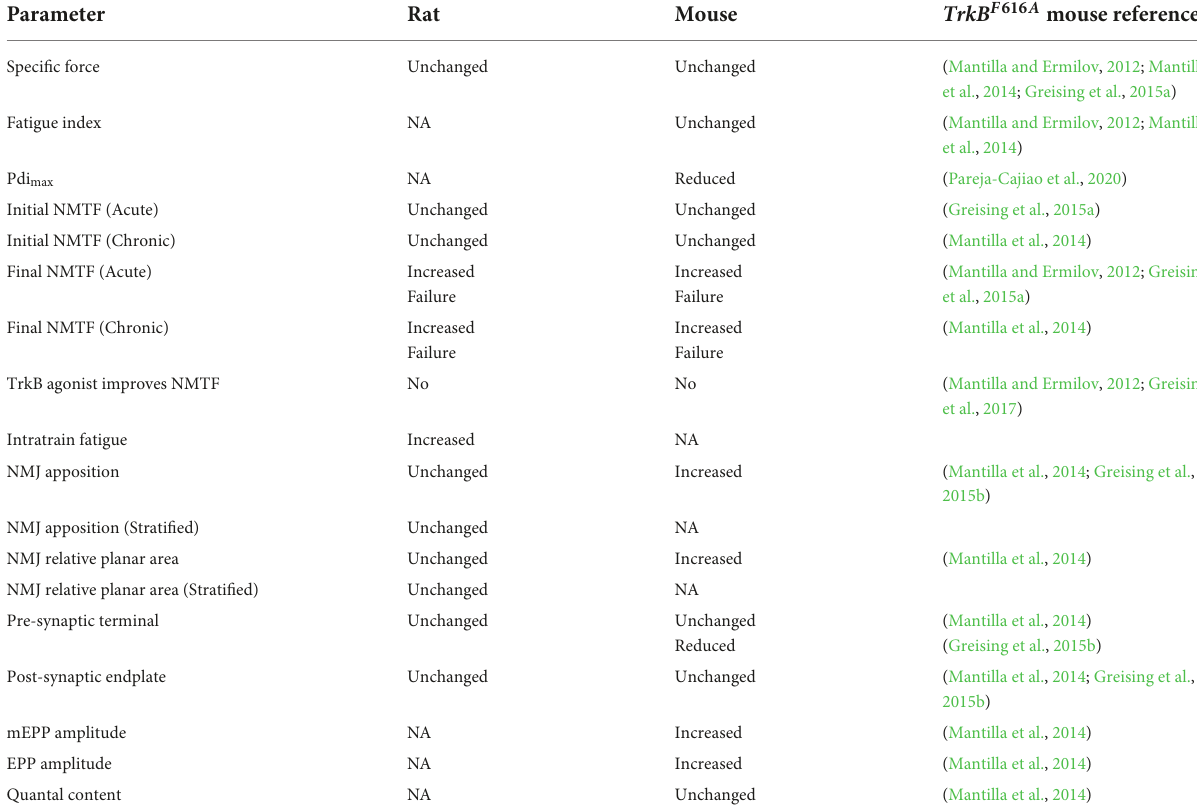
TABLE 2 Comparison of DIAm properties of TrkB F 616 rats and TrkB F 616 A